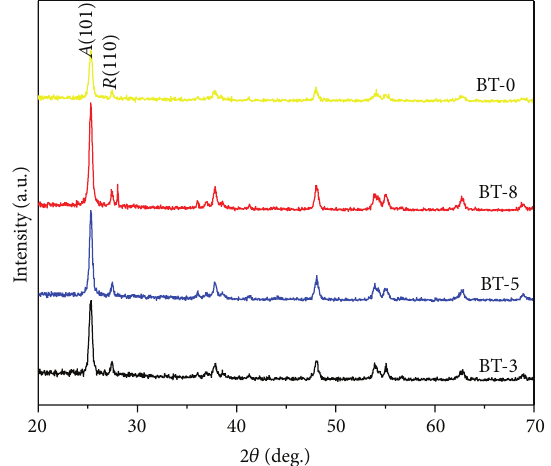
Figure 2: XRD patterns of undoped and boron doping TiO 2 nanoparticles including 8%, 5%, and 3.5% weight percentage assigned as BT-0, BT-8, BT-5, and BT-3, respectively. −1 (639 cm ), and one active mode, Eg (240 cm